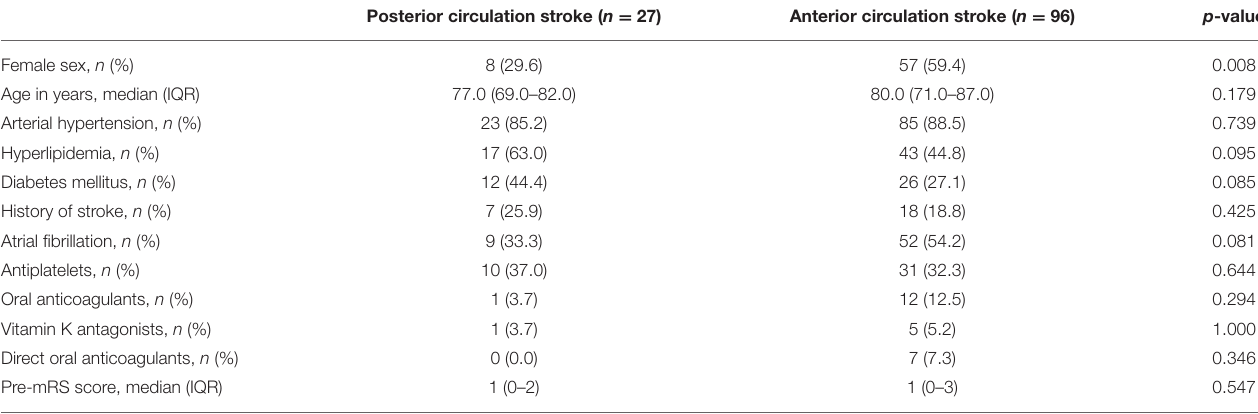
TABLE 5 | Baseline characteristics in the large vessel occlusion patient cohort.